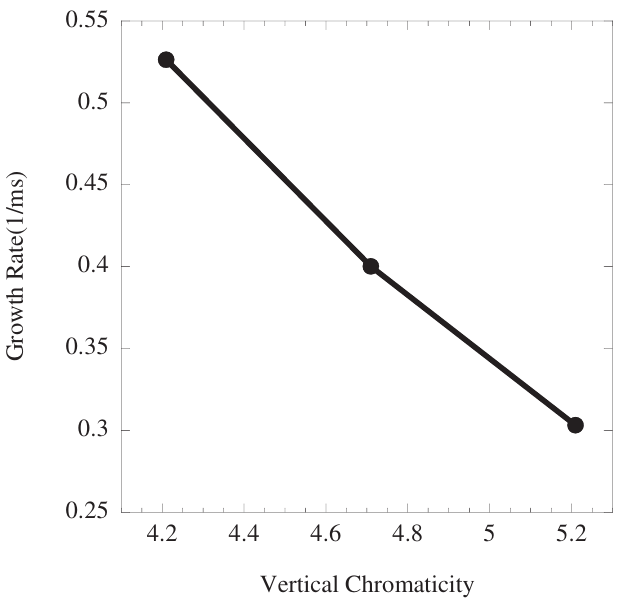
FIG. 2. Example of the change of the vertical growth rate of the instability with changing the vertical linear chromaticity. One point corresponds to one growth experiment. All weak solenoids were set at 0% of field